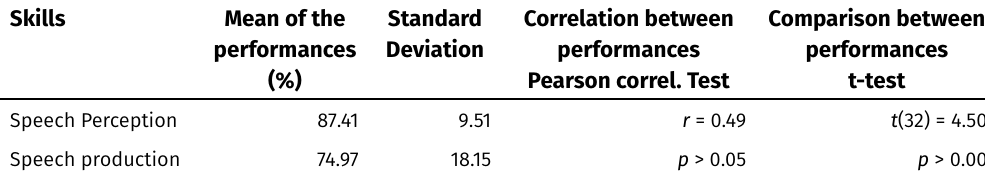
Table 1: Statistical analysis for speech production and speech perception performances.